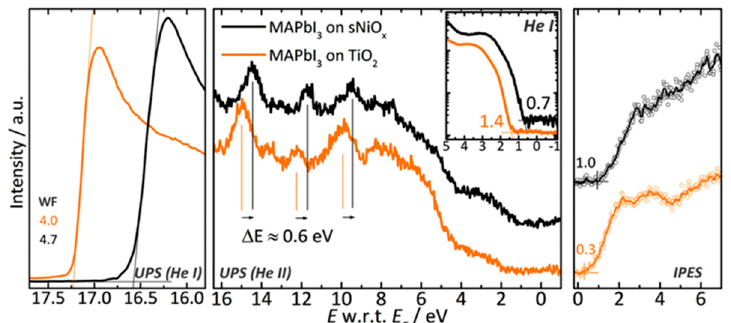
Figure 10. UPS and IPES spectra of MAPbI 3 on sNiO x (black curve) and MAPbI 3 on TiO 2 (orange curve). The left panel shows the secondary electron cutoff for work function determination. The middle panel shows the He II valence band spectra. The VBM measured with He I is shown in inset. The right panel shows the IPES spectra for the determination of the CBM [95]. Copyright © 2015 WILEY-VCH Verlag GmbH & Co. KGaA, Weinheim, Germany.